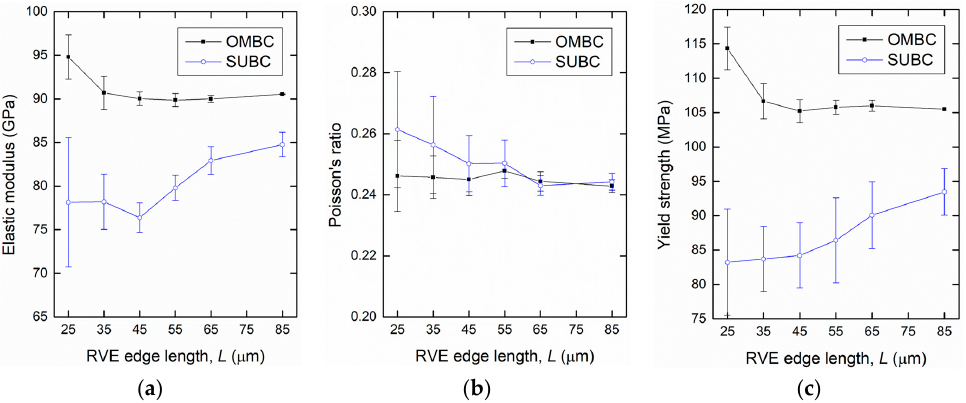
Figure 5. ( a ) Elastic moduli; ( b ) Poisson’s ratios; and ( c ) yield strengths obtained with the representative volume element (RVE) models subjected to different boundary conditions as a function of their edge lengths. Black lines with rectangular marks represent the orthogonal mixed boundary condition (OMBC). Blue lines with circular marks represent the static uniform boundary condition (SUBC).